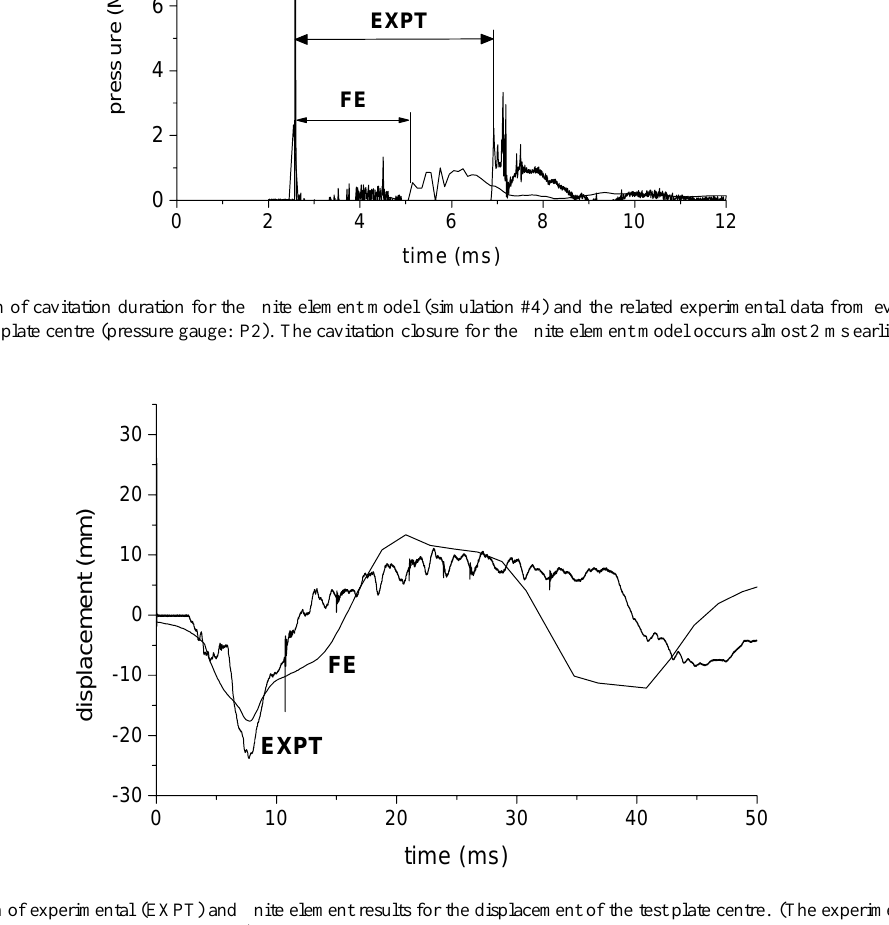
Fig. 7. Comparison of experimental (EXPT) and finite element results for the displacement of the test plate centre. (The experimental data was acquired using an optical displacement